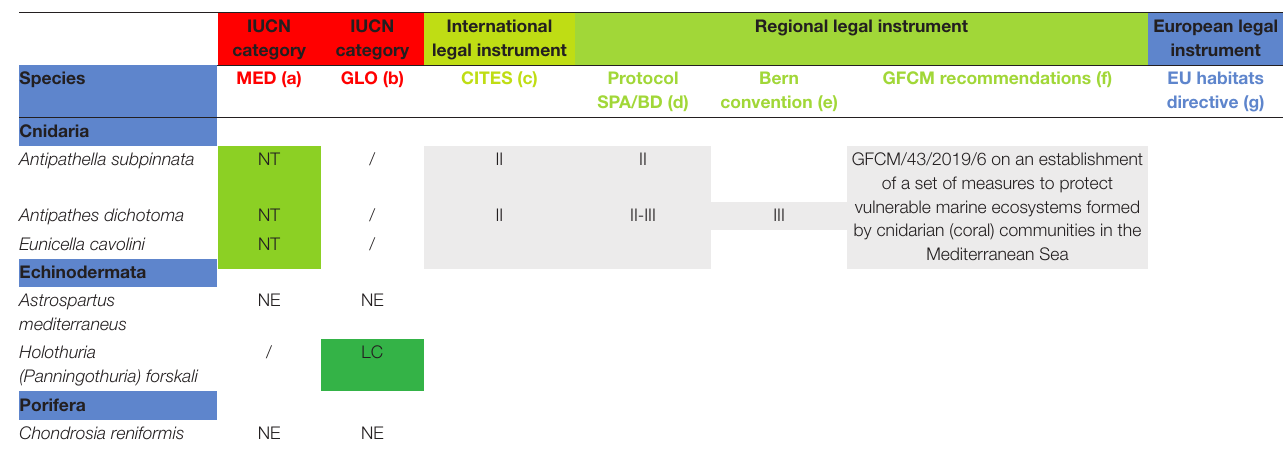
TABLE 1 | List of the species we were able to recognize in the study area.